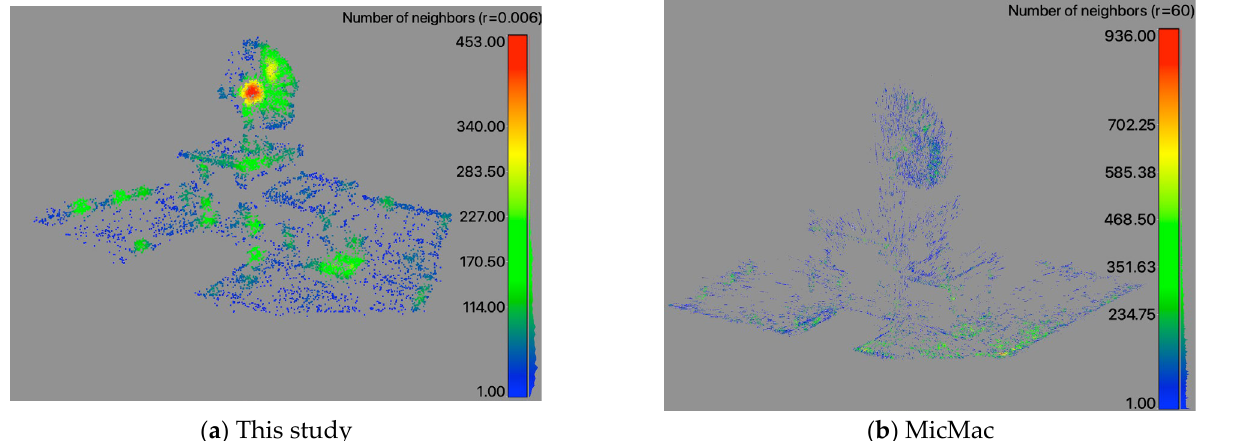
Figure 16. Density evaluation of a small shift on the reconstruction in CloudCompare.